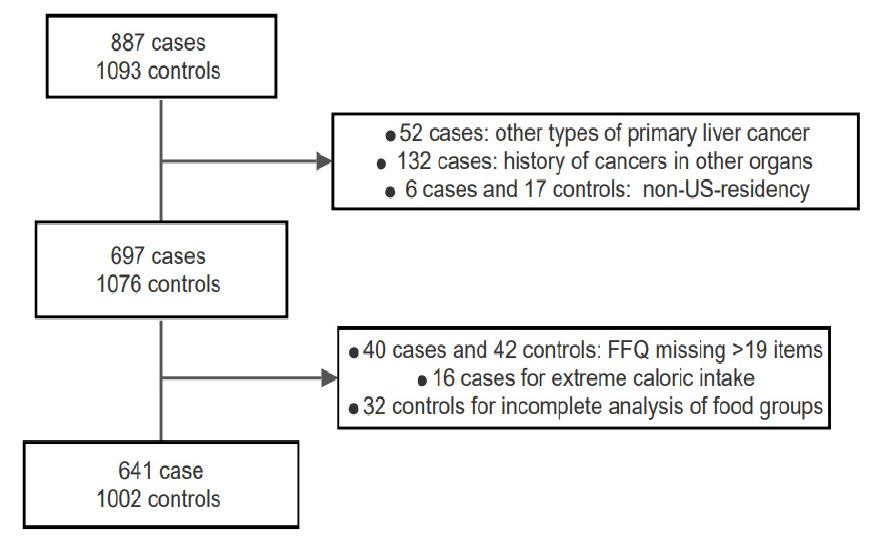
Figure 1. Inclusion flow chart for cases and controls.